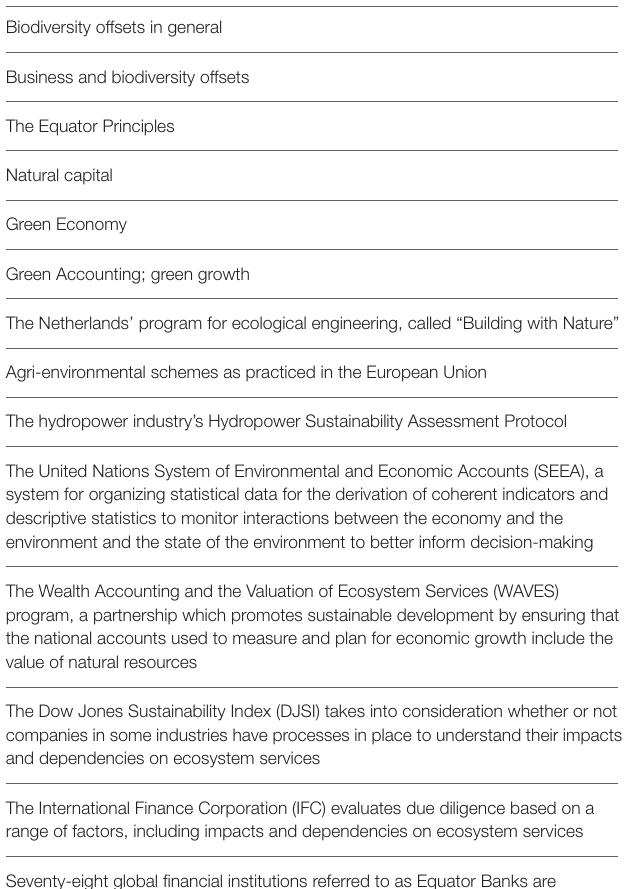
TABLE 1 | Programs with objectives and approaches that are, or overlap with, biodiversity mainstreaming but do not use the term “mainstreaming” (details and references in Huntley and Redford,